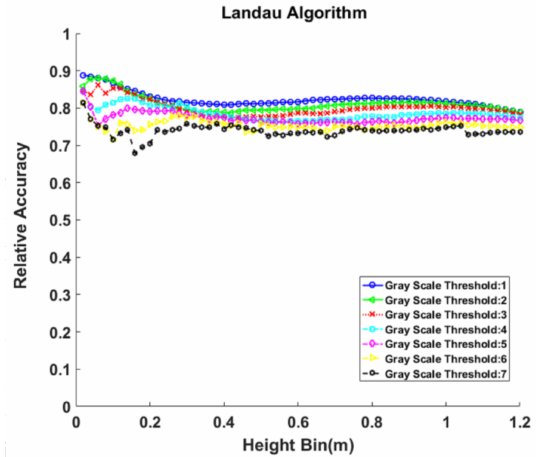
Figure 17. The relative accuracy of Landau algorithm under different height bins and gray scale thresholds in single-scan mode of the